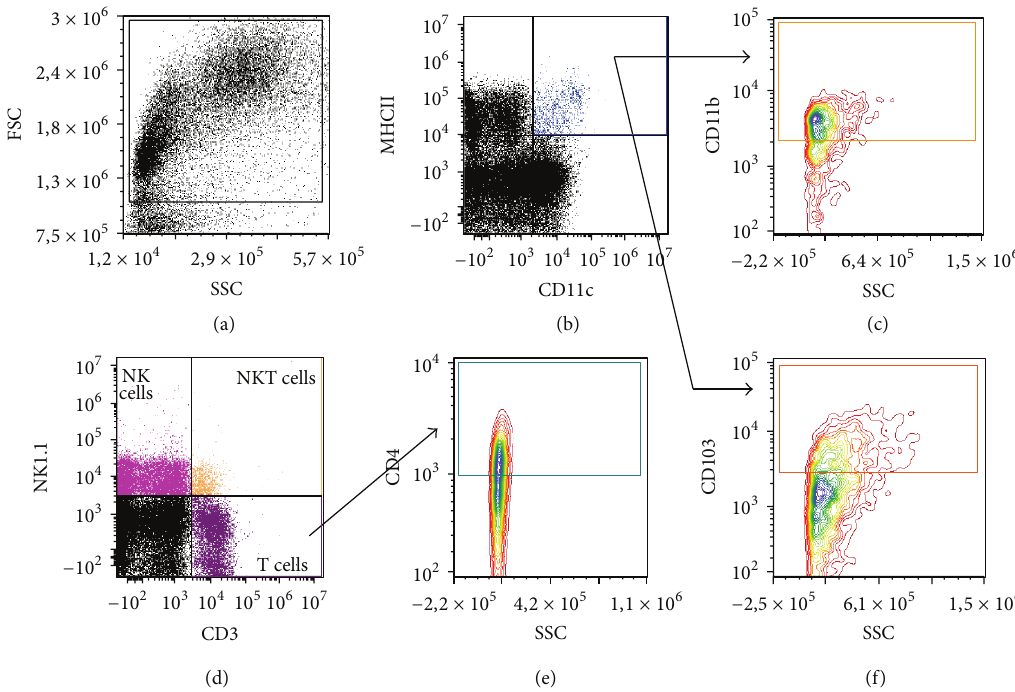
Figure 1: Gating strategy for the analysis of immune cells in murine atherosclerosis. Gates are set on isotypes to correct for nonspecific binding. (a) Plots are pregated on FSC and SSC to define the total percentage of leukocytes from cell debris. (b) The total cDC population was identified based on the expression of CD11c and MHCII. (c, f) Based on their expression of CD11b (c) and CD103 (f) two cDC subsets were identified. A distinction was made between circulating Ly-6C high and Ly-6C low monocytes and tissue resident macrophages (plots not shown). (d) Lymphocyte subsets were identified as T cells (CD3 + NK1.1 − ), NK cells (CD3 − NK1.1 + ), and NKT cells (CD3 + NK1.1 + ). (e) Th cells were defined as CD4 + cells within the total T cell